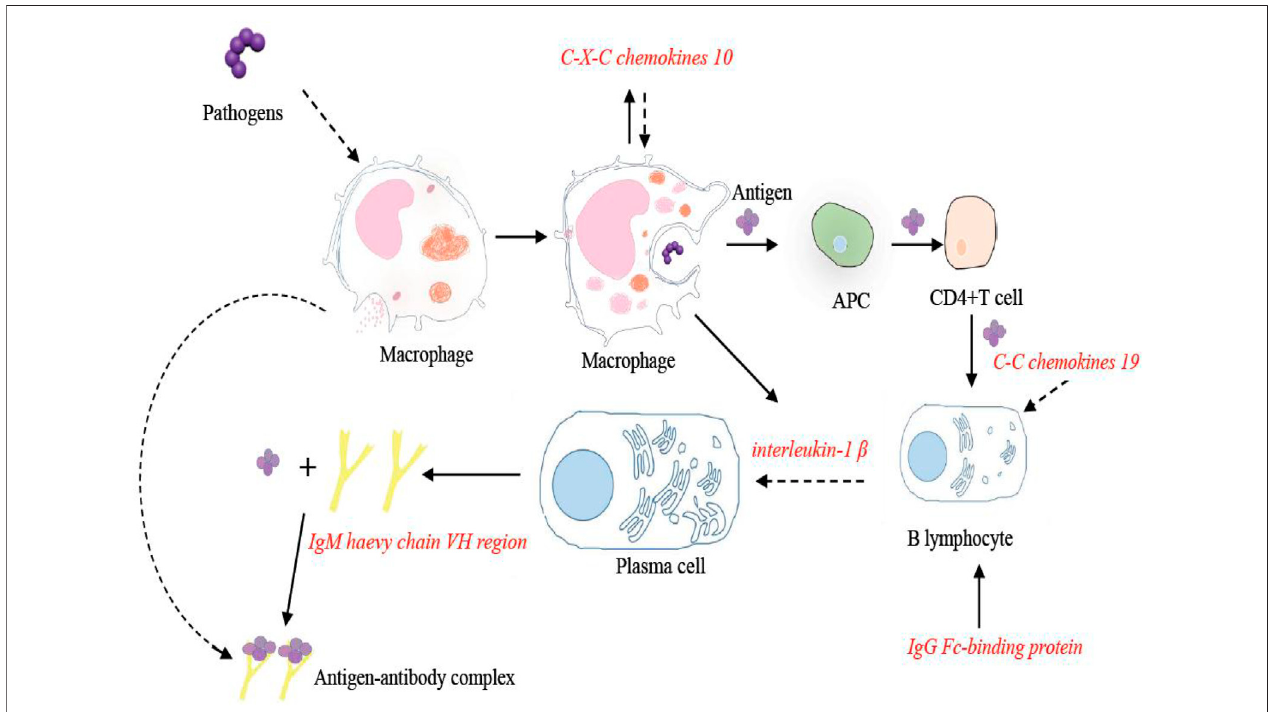
FIGURE 6 | Immune pathways of CXCL 10 , C-C motif chemokine 19-like , interleukin-1 beta-lik e, IgM heavy chain VH region, partial , and IgG Fc-binding protein in the O. niloticus intestine.